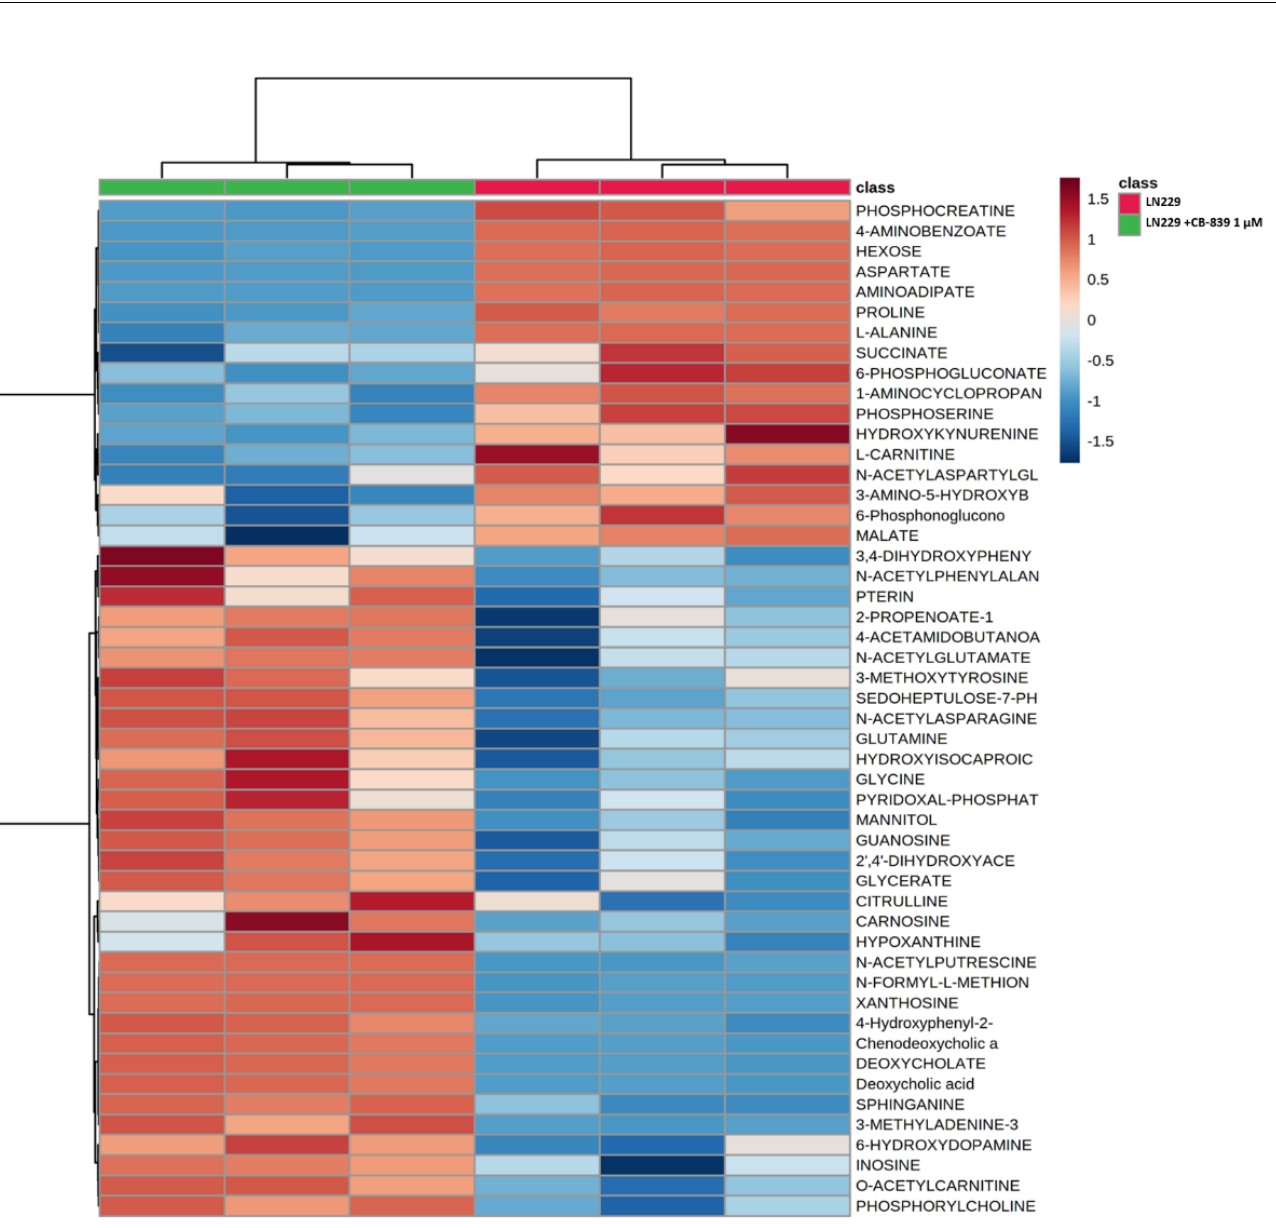
Figure 5. Metabolomic changes elicited by CB-839 are depicted on a representative hierarchical clustering analysis of key molecules in the LN229 glioma cell line. The heat map shows the top 50 differentially altered metabolites in GBM cells exposed for 24 h to 1 µ M CB-839. The samples were run in triplicate. For more details, see Section 2.